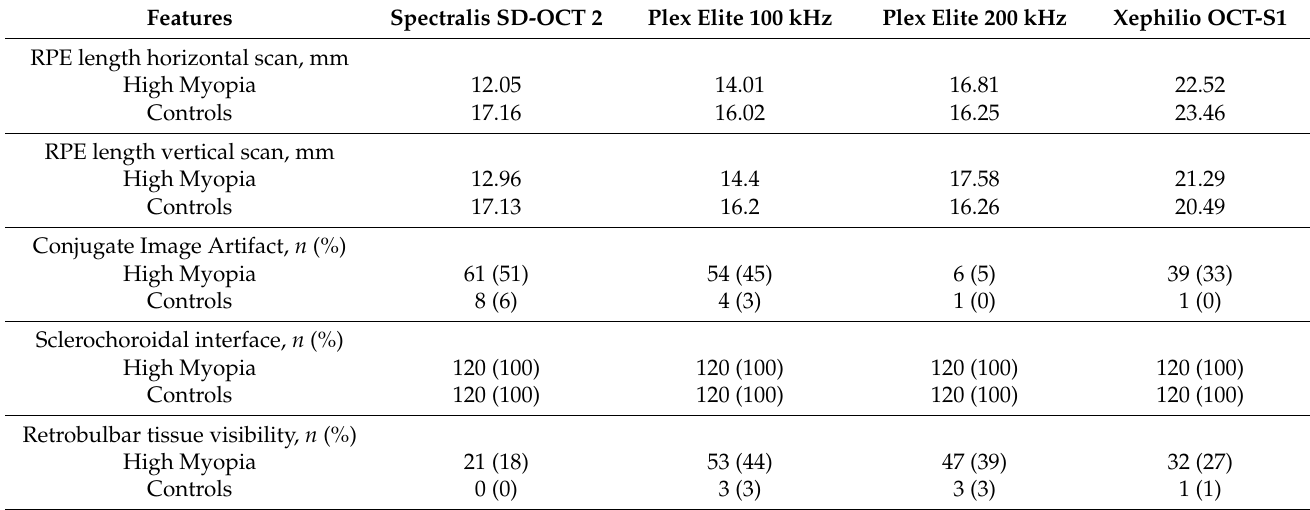
Table 2. OCT findings in high myopia cohort and emmetropic